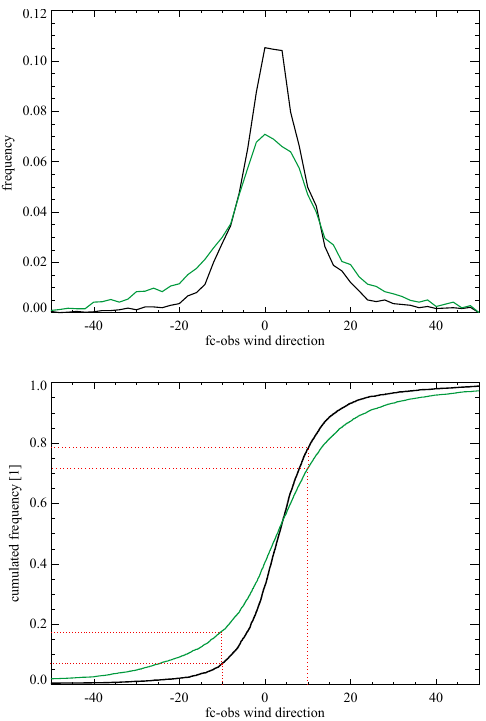
Figure 9. ( Top ) Probability distribution and ( bottom ) cumulative probability distribution of the difference between the forecasted and observed wind directions. Black line represents lead time of one day (0–24 h) and green line represents lead time of three days (49–72